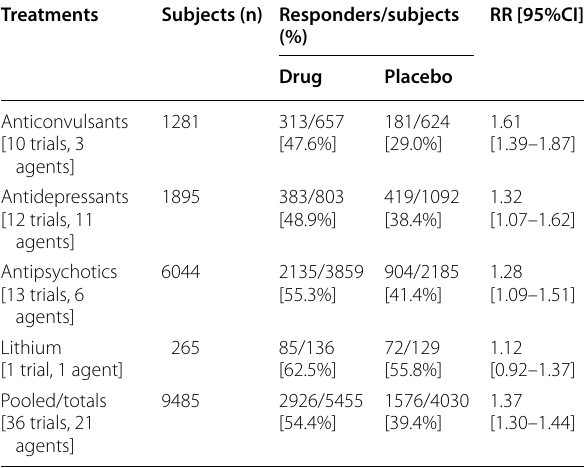
Table 4 Placebo-controlled trials for acute depression in bipolar